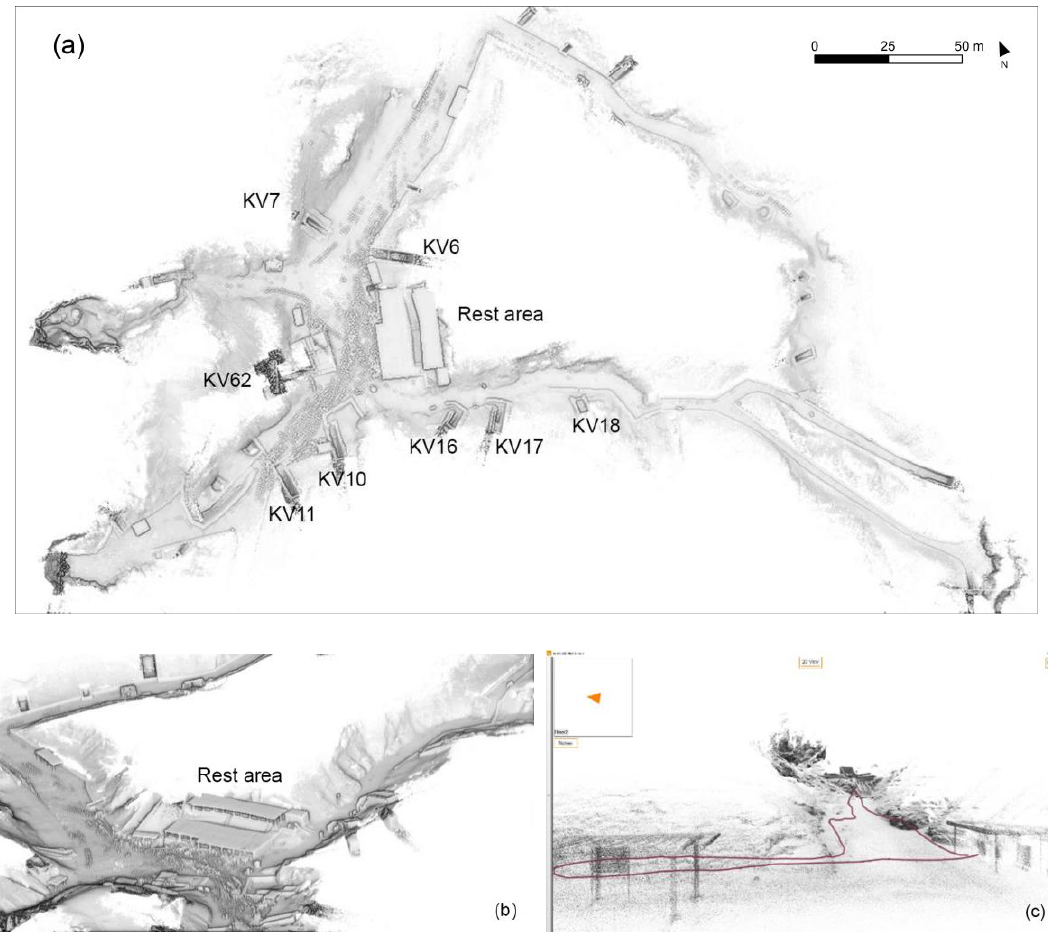
Figure 5. Mobile Mapping System survey: ( a ) the plan view of several registered point clouds acquired by MMS (b,c) Some views of the 3D model, in shaded features ( b ) and with the trajectory ( c ).